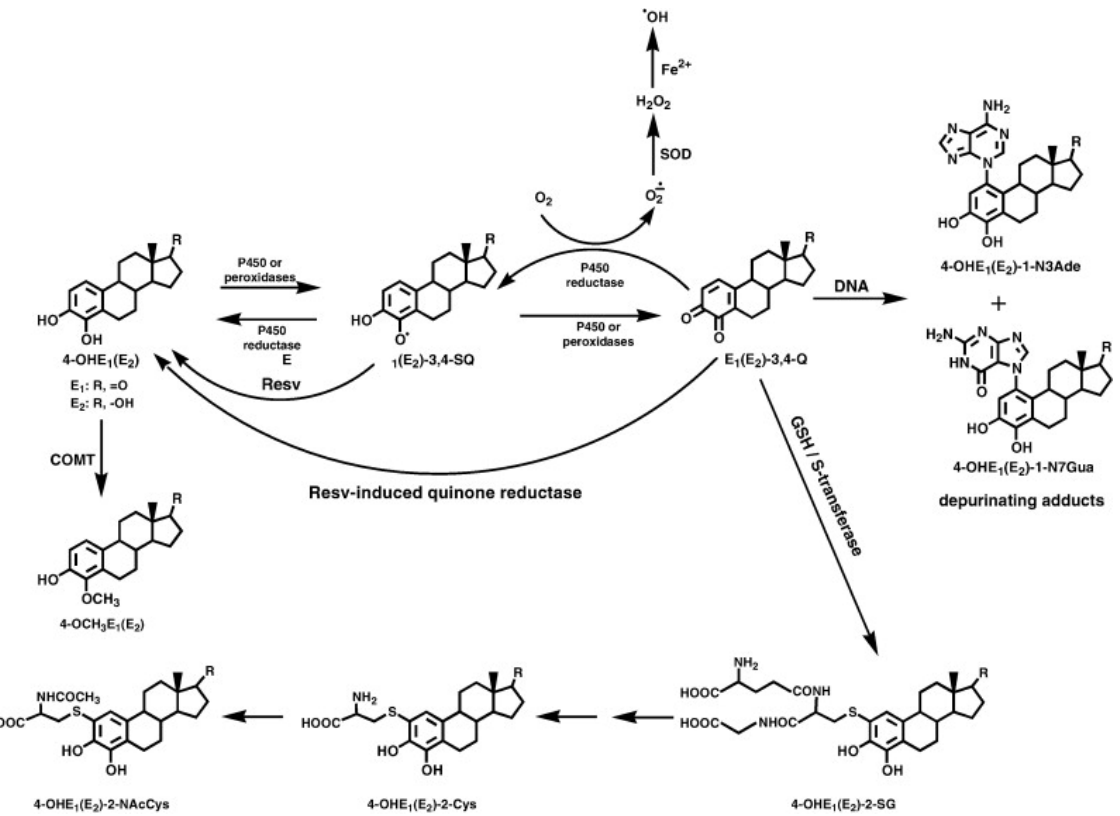
Figure 3. Mechanisms by which resveratrol can prevent estrogen-initiated breast cancer (with permission from [68]). Quinones formed by the estrogens’ metabolism can also be detoxified through conju- gation with glutathione (GSH) by the glutathione- S -transferase (GST) enzyme [103]. The most common estrogen present in the breast is 17 β -estradiol (E 2 ). This hormone is hydroxylated to catechol-estrogens, such as 2- and 4-hydroxyestradiol (2-OHE 2 and 4-OHE 2 , respectively). The catechol-estrogens are then methylated by the COMT enzyme, forming 2-methoxy-E 2 and 4-methoxy-E 2 , respectively